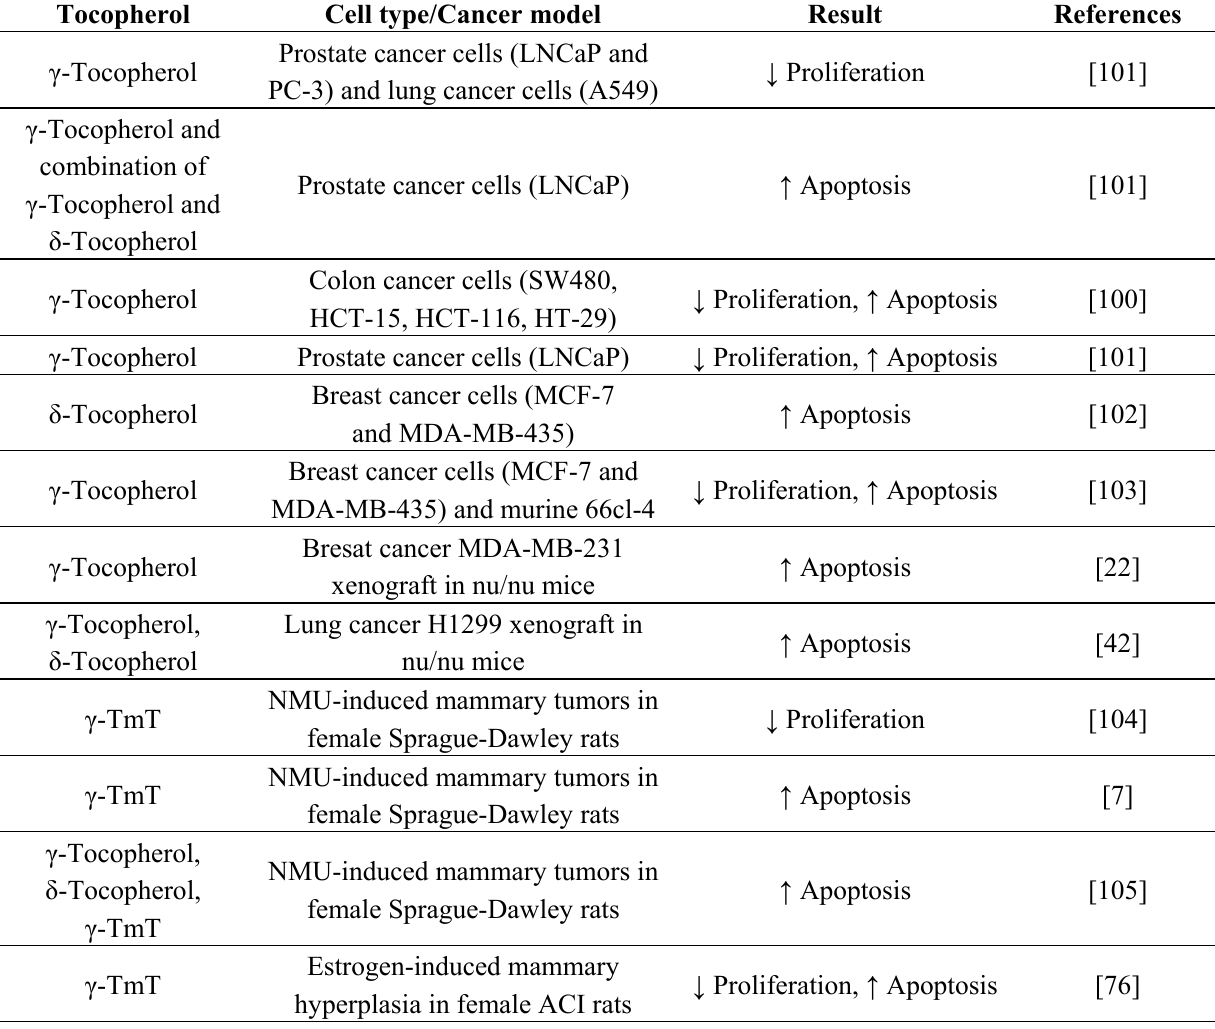
Table 3. Tocopherols inhibit cell proliferation and induce